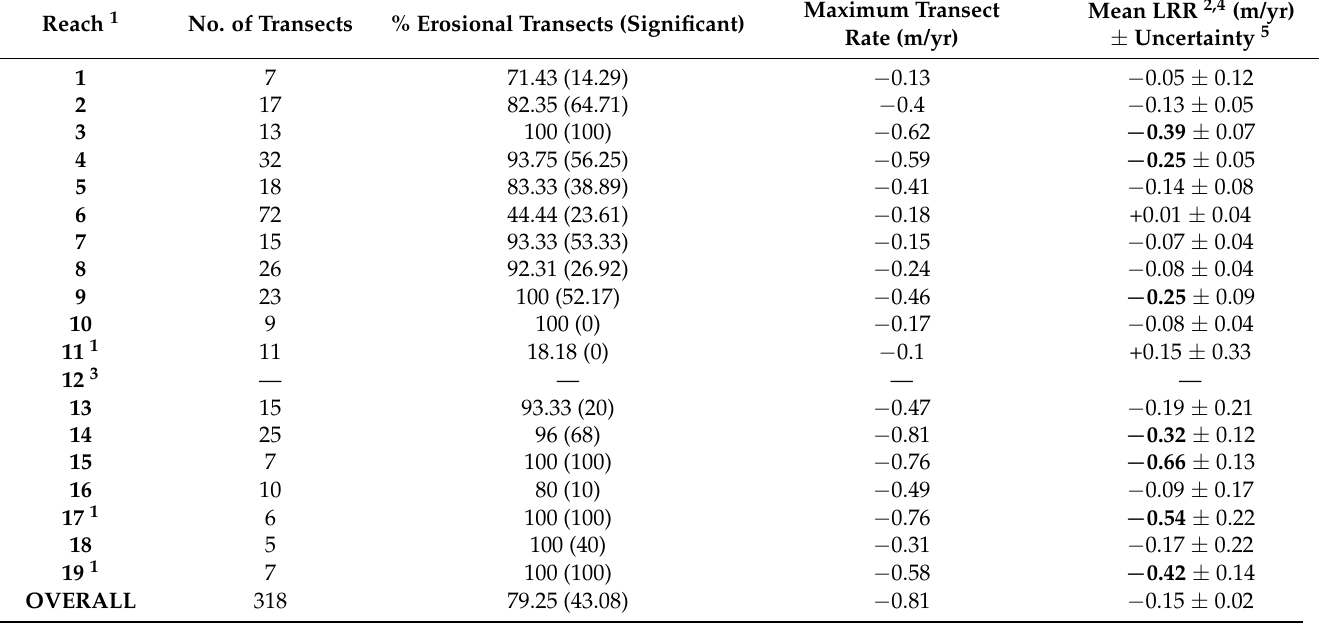
Table 6. Long-term coastline change analysis results. Analysis included nine historical aerial photographs, spanning 84 years: 1934, 1954, 1965, 1972, 1981, 1994, 2006, 2015, and 2018. Transects were cast at 20 m intervals. Results include the percent of erosional transects per reach, the transect with the largest change rate per reach, and the mean linear regression rate (LRR) for each reach with calculated